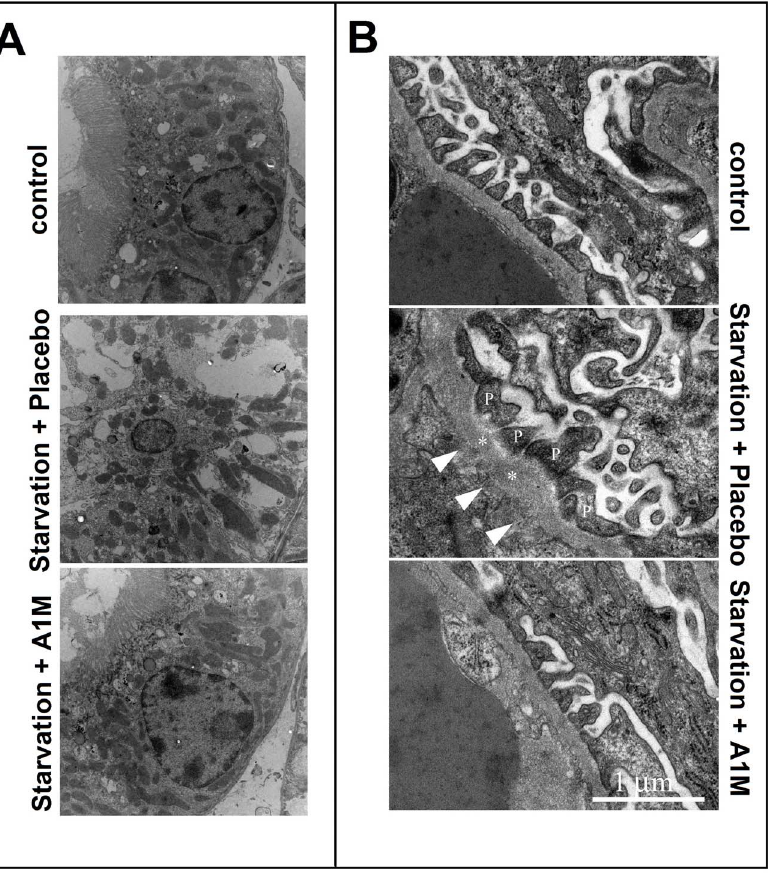
Figure 8. Ultra structure of renal tissue visualized by transmission electron microscopy. Panel A shows a representative areas of the proximal tubules with morphologically intact tubular cell linings seen in the control animals (upper panel) and in the starved animals treated with A1M (lower panel). In contrast, starvation and placebo treatment led to severe tubular damage and cell necrosis (middle panel). Panel B shows the glomerular area. The arrows point at abnormal regions on the basement membrane with fenestrations underneath. The podocytes show a disturbed morphology. The asterisks mark the basal membrane and P indicates the podocyte cell bodies.